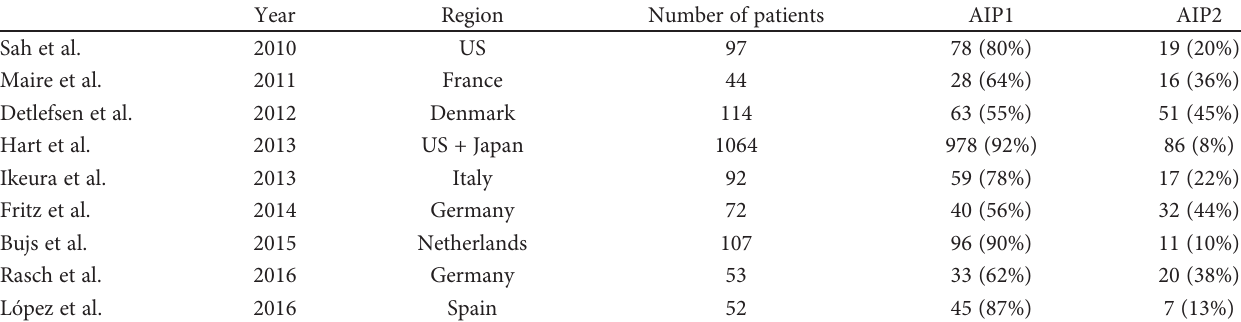
Table 4: Distribution of AIP1 and AIP2 patients in the western hemisphere according to current